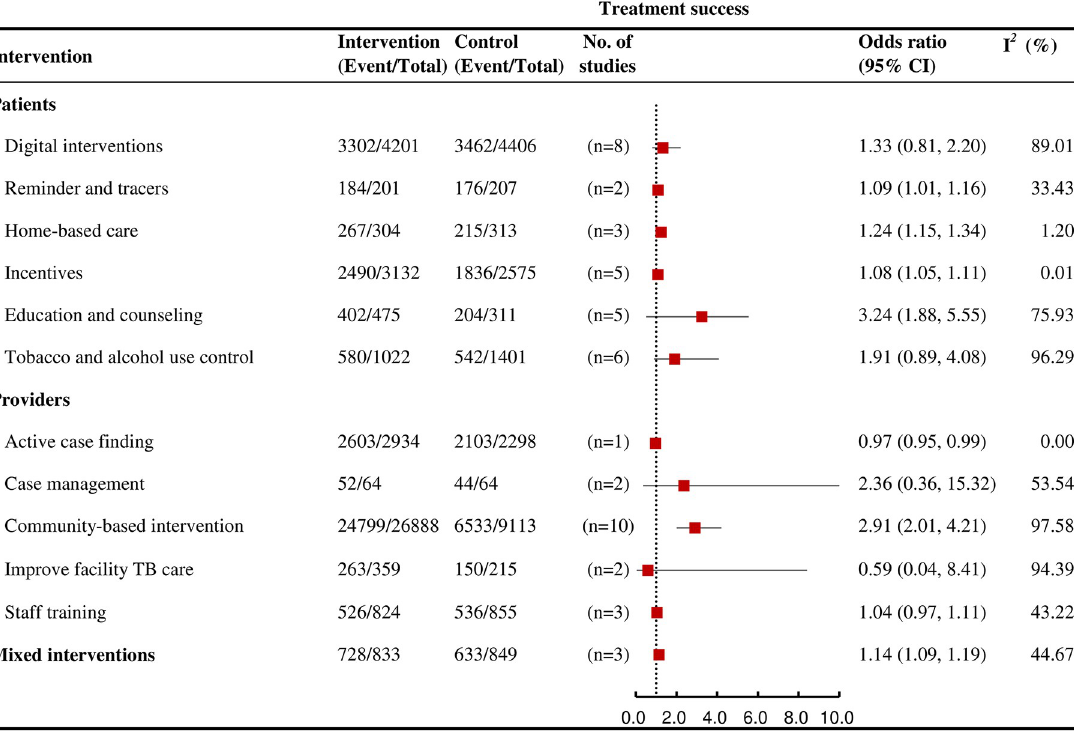
Fig 8. Forest plots showing the effects of various interventions on TB treatment success outcomes for active TB.